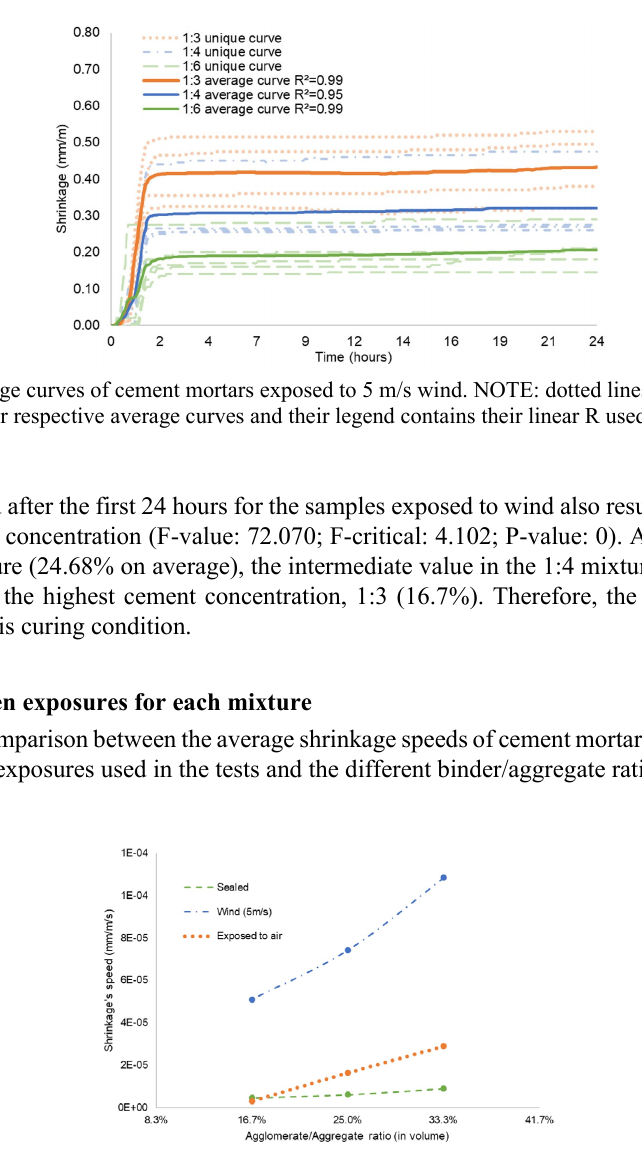
Figure 13. Average early shrinkage speeds of cement mortars under different air exposure